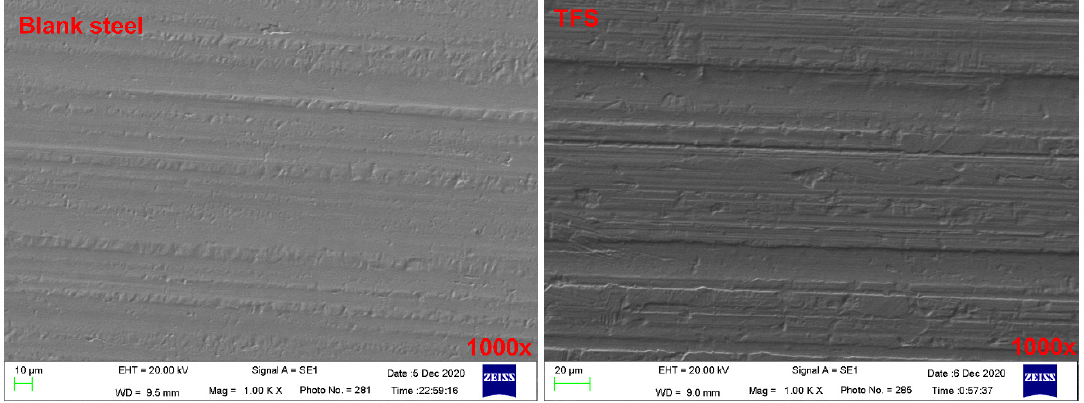
Figure 6. The SEM images of blank steel and TFS.